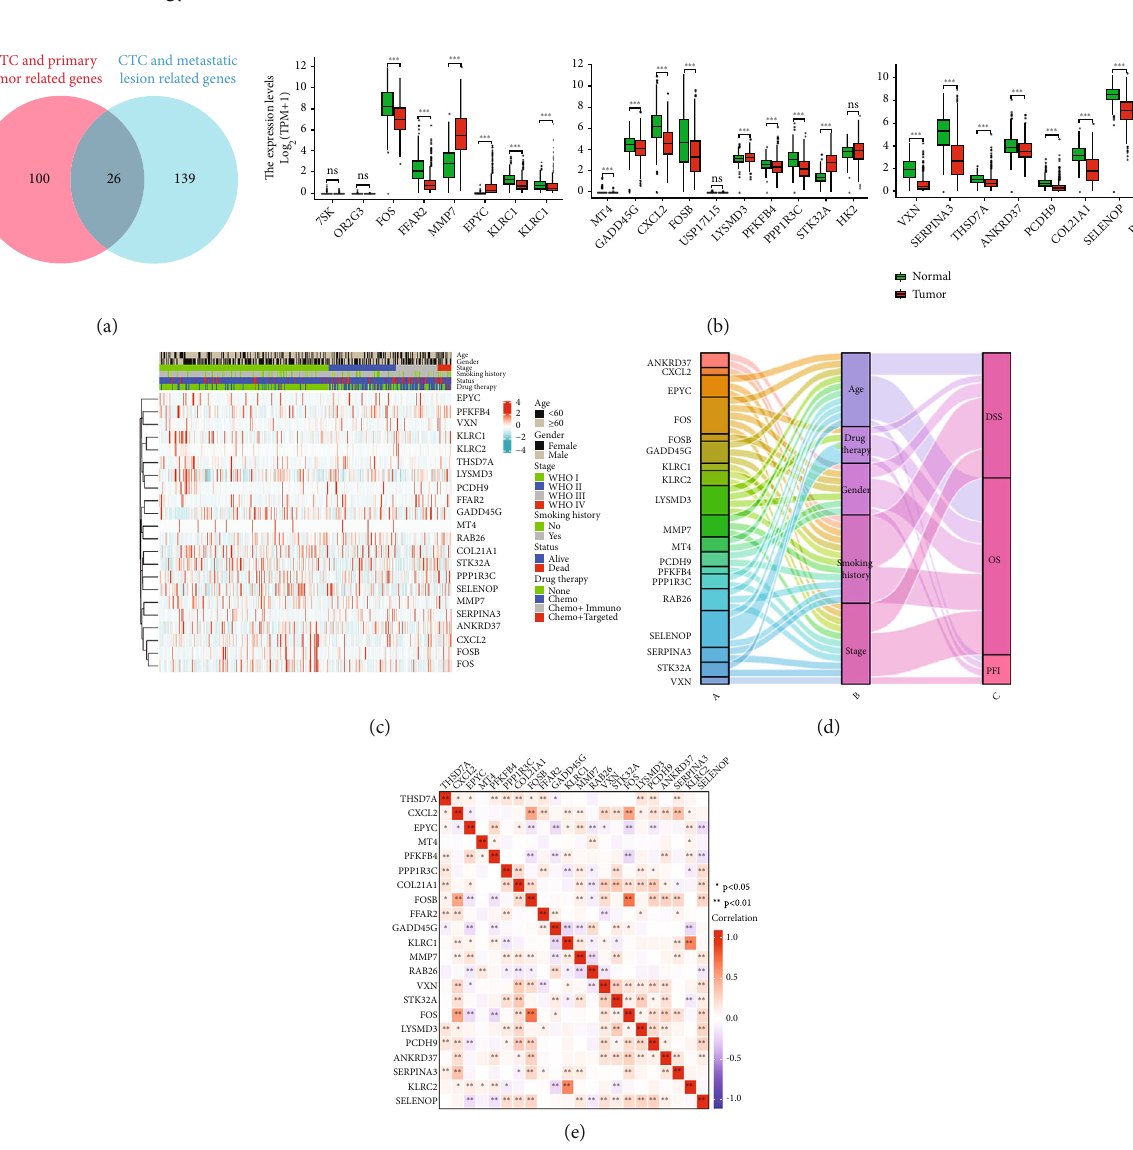
Figure 2: Identi fi cation and analysis of CTC-related DEGs in patients with LUAD. (a) Venn diagram demonstrating genes related to CTCs, primary tumour and metastasis. (b) The expression level of 26 overlapping genes in tumour samples in TCGA-LUAD cohort (n =447) and normal samples in the GTEx dataset (n =347). (c) Unsupervised clustering of DEG expression in TCGA cohort. The age, sex, tumour stage, smoking history, survival status and drug therapy are used as patient annotations. (d) Sankey diagram demonstrating the degree of association among DEGs, clinical features and prognosis. (e) Heat map demonstrating the correlation among 22 genes in TCGA-LUAD cohort. The asterisks represent the statistical p -value ( ∗ p < 0 : 05 ; ∗∗ p < 0 : 01 ; ∗∗∗ p < 0 : 001